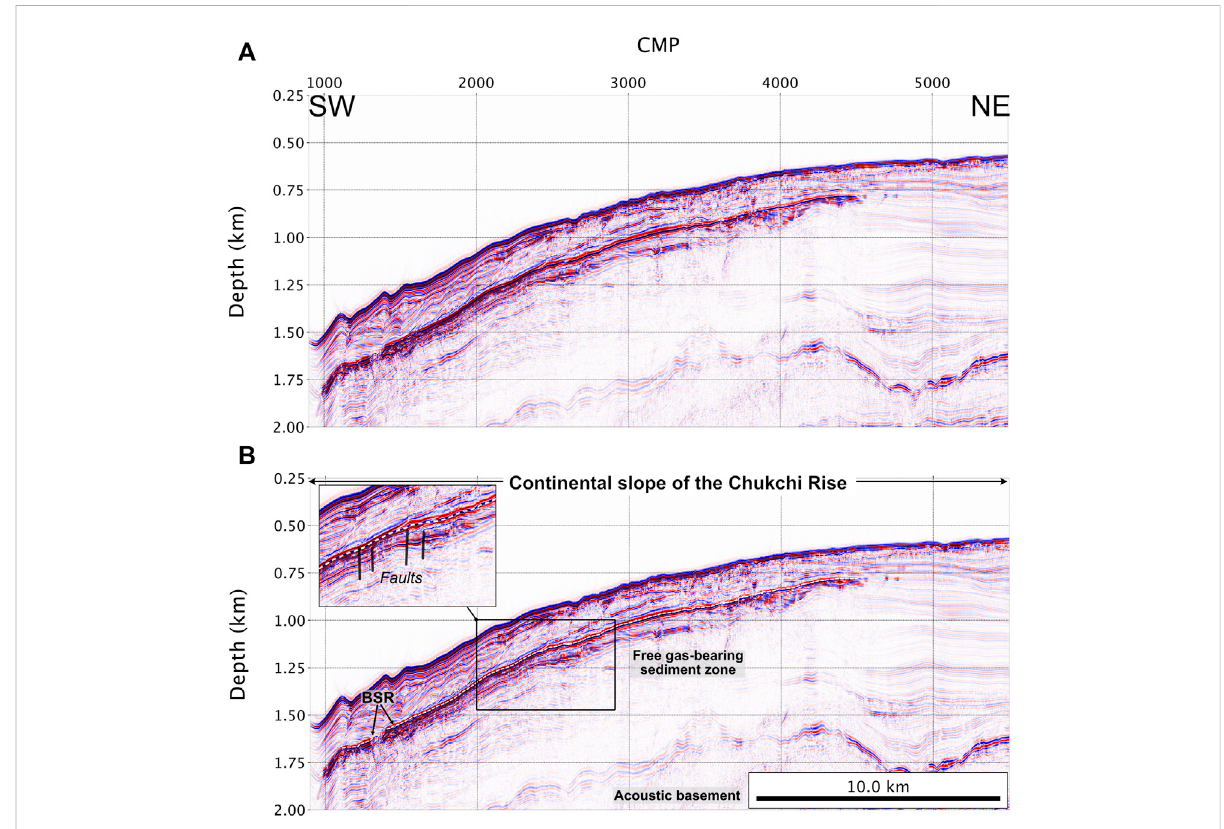
FIGURE 7 (A) Uninterpreted and (B) interpreted migrated seismic images obtained from the MCS04